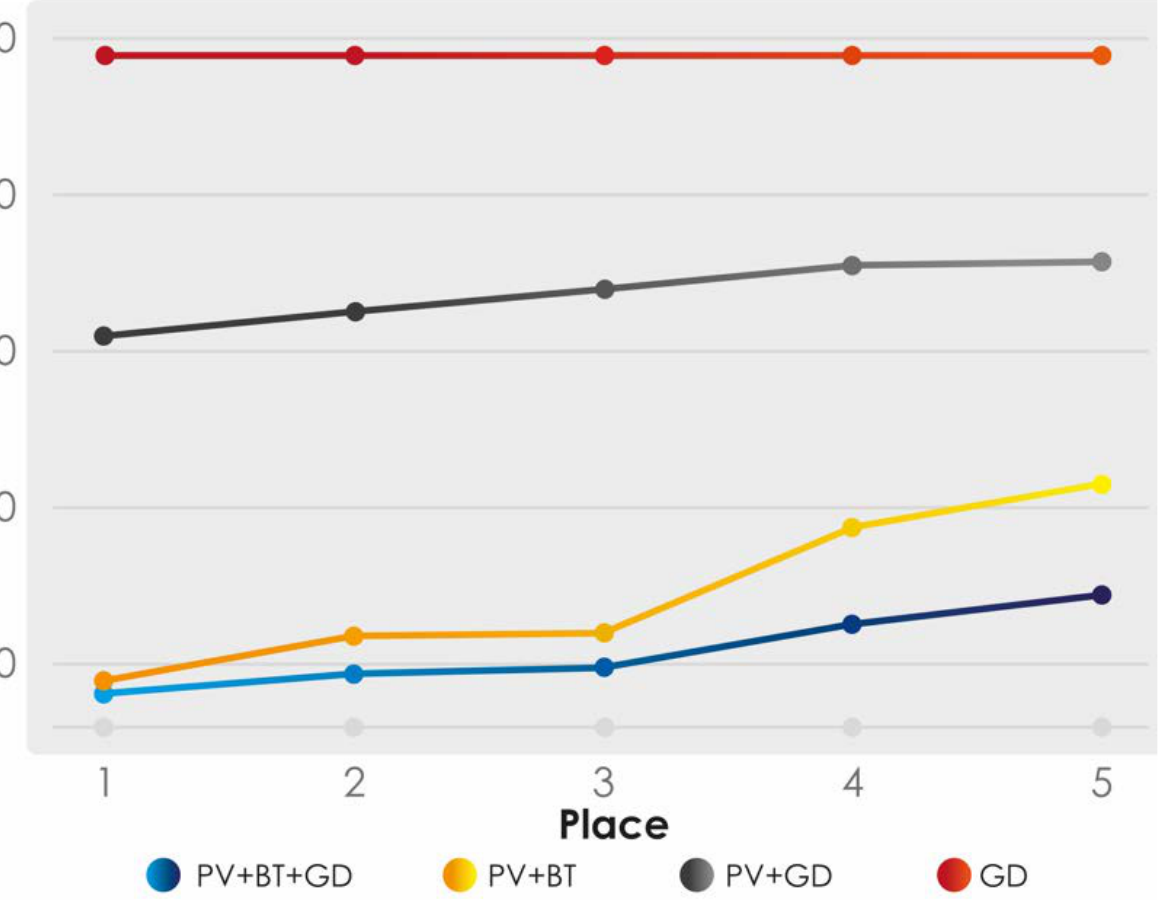
Figure 5. Costs vs.